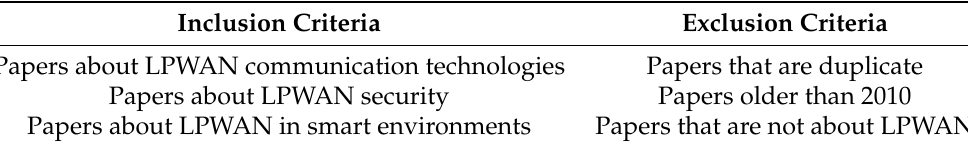
Table 2. Inclusion and Exclusion criteria for this systematic